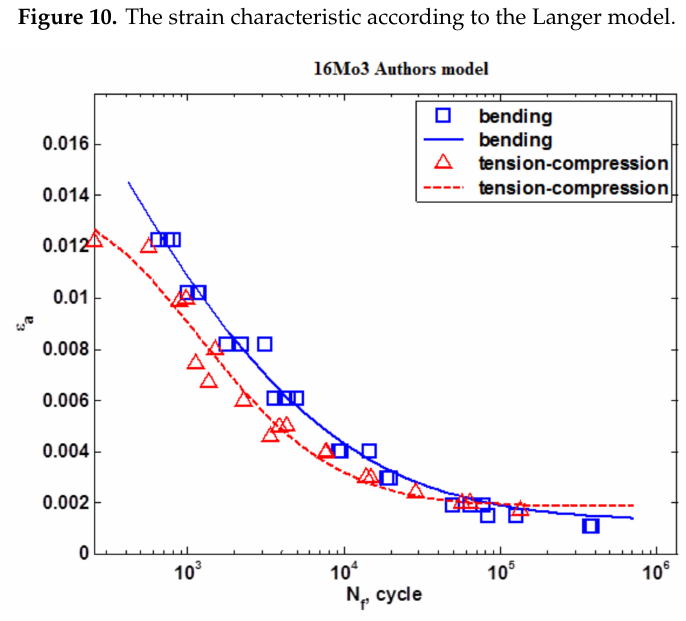
Figure 11. The strain characteristic according to the model proposed by the author.